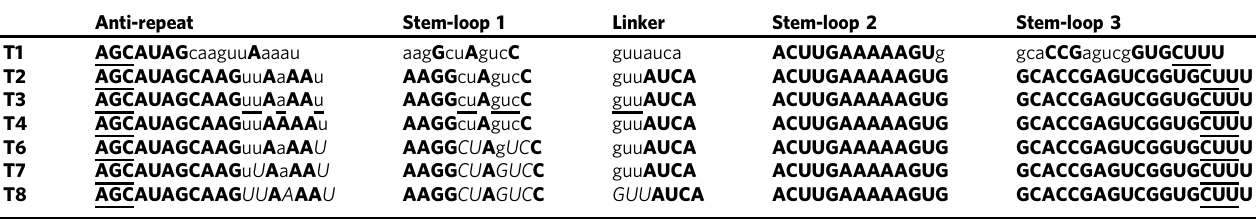
Table 2 Chemically modi fi ed tracrRNAs used in this study